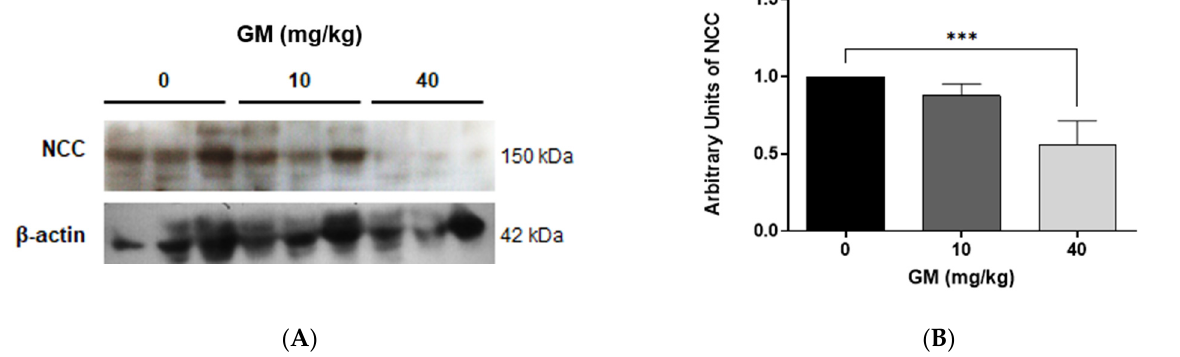
Figure 5. NCC protein levels in renal tissue decrease only with 40 mg/kg/day of GM. ( A ) Representative blot of NCC and β -actin from whole renal tissue of untreated and GM-exposed mice; ( B ) Bar graph shows means ± SD of normalized densitometries. n = 5 animals per dose. One-way ANOVA was performed, p < 0.0001. Post-hoc: Dunn test *** p < 0.005.